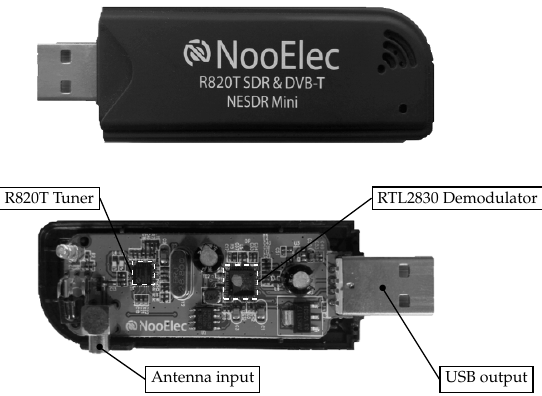
Figure 12. Covered and uncovered version of a NooElec TM NESDR Mini DVB-T dongle used as an software-defined radio (SDR) with an R820 tuner, RTL2832 demodulator and USB